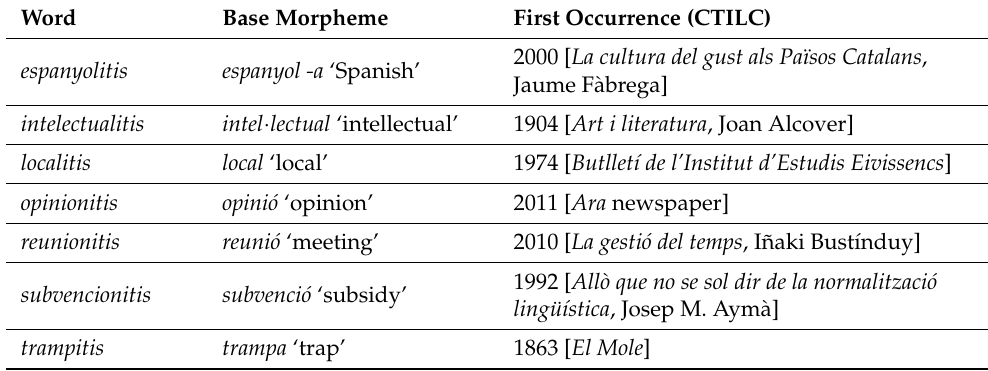
Table 1. Lexical innovations with the combination form - itis registered in the CTILC.